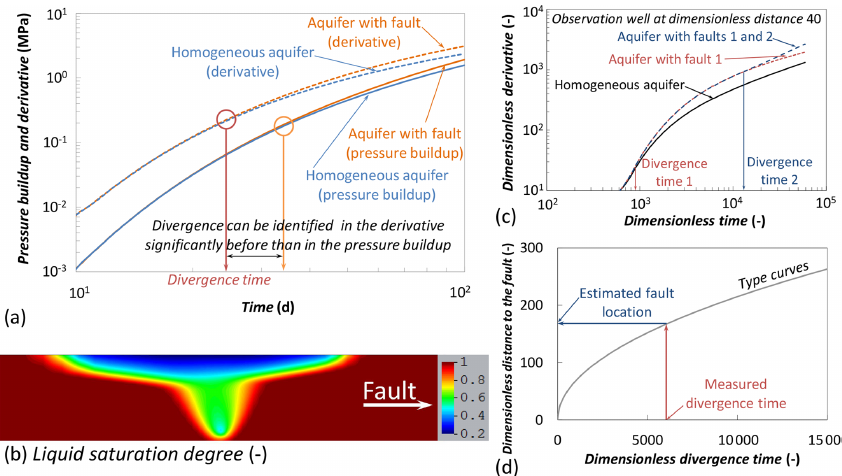
Figure 9. (a) Concept of the continuous characterization technique proposed by Vilarrasa et al. (2017a) to detect and locate low-permeability faults using diagnostic plots; (b) asymmetric CO 2 plume as a result of the additional pressurization caused by a low-permeability fault, which displaces CO 2 towards the opposite direction of the fault; (c) detection of multiple faults by updating the conceptual model of the site and comparing field measurements with predictive simulations; and (d) estimation of the fault location from the measured divergence time in the derivative of the pressure evolution using type